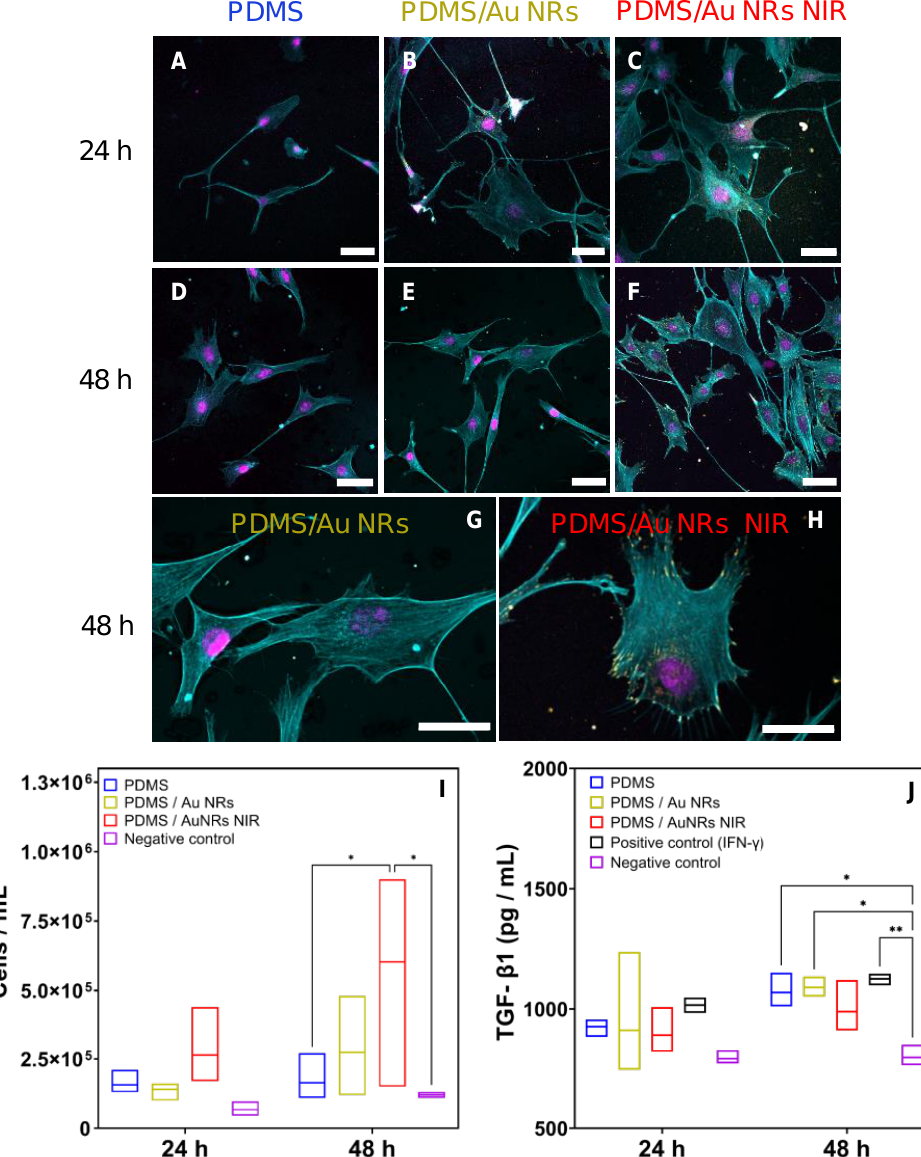
Figure 3. ( A – F ) cLSM images of NIH/3T3 fibroblast cultured on the films for 24 and 48 h. Cell nuclei (magenta), f-actins (cyan), and paxillin (yellow) were stained, respectively. Scale bar 40 µ m. ( G , H ) Zoomed images of the fibroblasts cultured on non-irradiated PDMS/Au NRs films and PDMS/Au NRs NIR films at 48 h of cultivation. Scale bar 40 µ m. ( I ) Number of NIH/3T3 by automatic counting using an EVE TM counter ( n = 3) after 24 and 48 h. ( J ) Secretion of TGF- β 1 after 24 and 48 h (19000 cells/cm 2 ). IFN- γ (1 µ g/mL) was used as a positive control. Glass was employed as the negative control. Two-way ANOVA, post hoc Tukey’s test, * p ≤ 0.05, ** p ≤ 0.01.